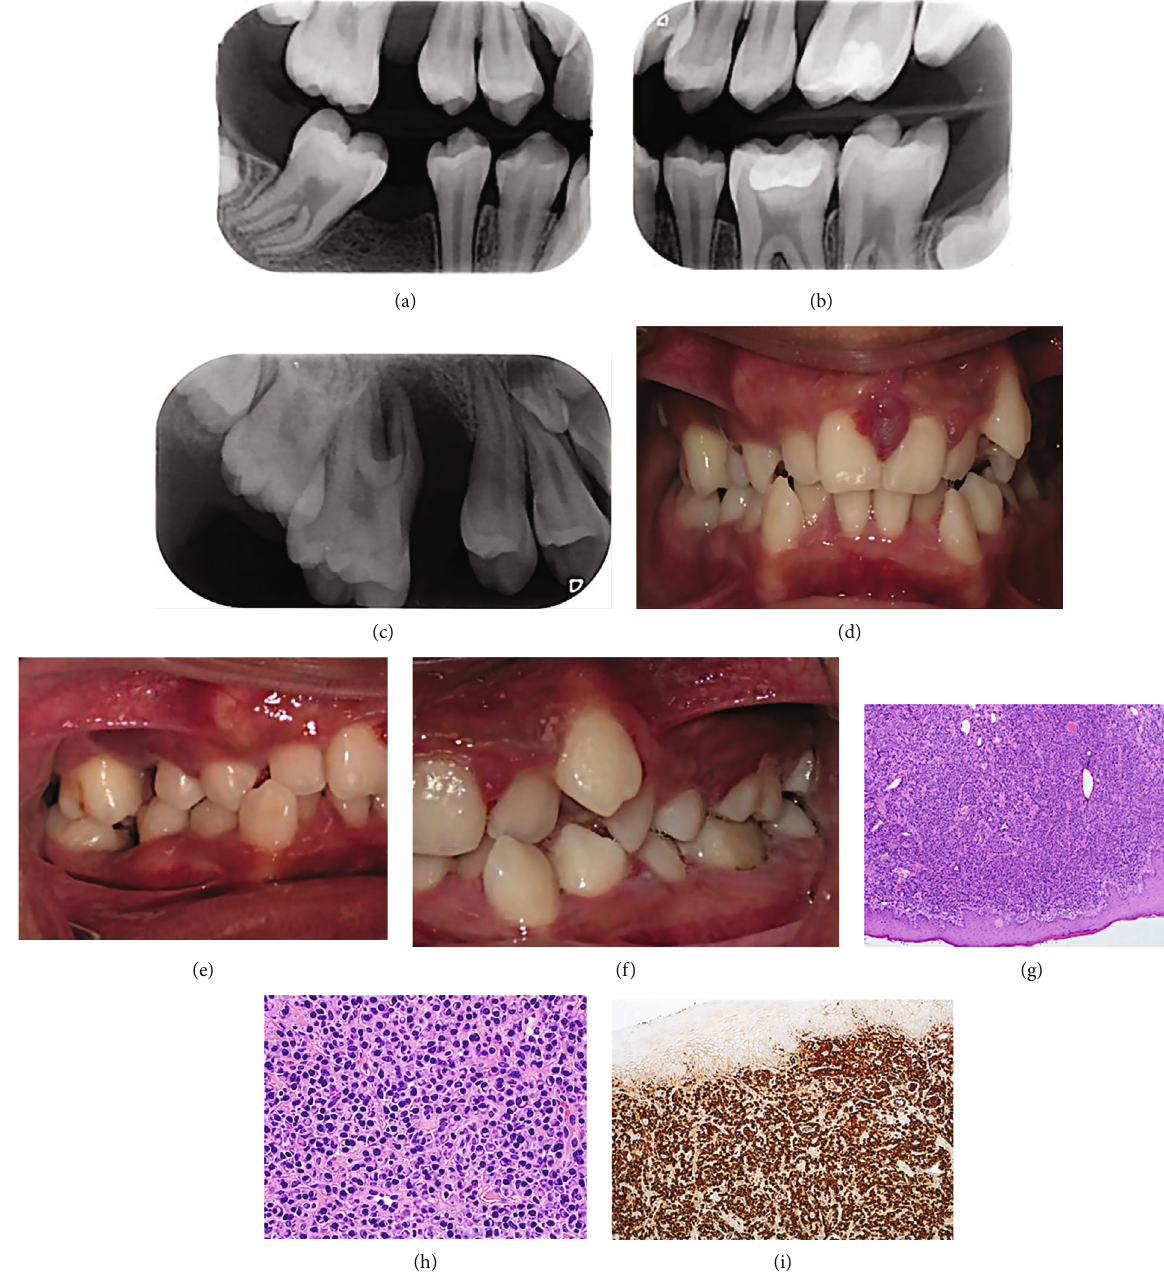
Figure 2: (a) – (c) Follow-up radiographs at 6 months. (d) – (h) Intra-oral views at 6 months follow-up. (h) and (i) Hematoxylin & eosin stained images of second excisional biopsy of interdental gingival lesion to teeth #8 and #9 showing. (i) Hyperplastic squamous mucosa with underlying nodular sheet-like plasma cells in a background of collagenized stroma composed of fi broblasts and myo fi broblasts. (j) High power view showing morphologically monotonous and di ff used cells with no mitotic fi gures or nuclear atypia indicative of plasma cell in fi ltrate. (k) Immunostains for kappa and lambda showing a strong di ff used positivity with no light chain restriction. Findings were indicative of polyclonality of the